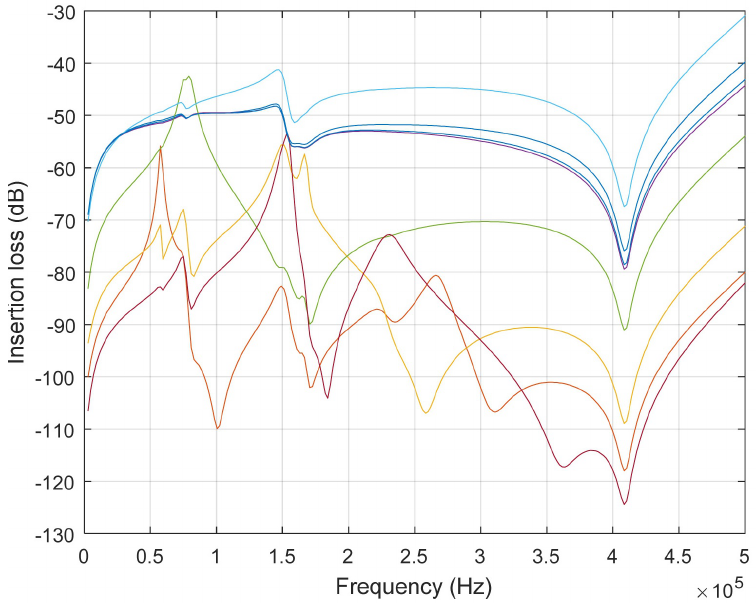
Figure 8. The IL of 8 random